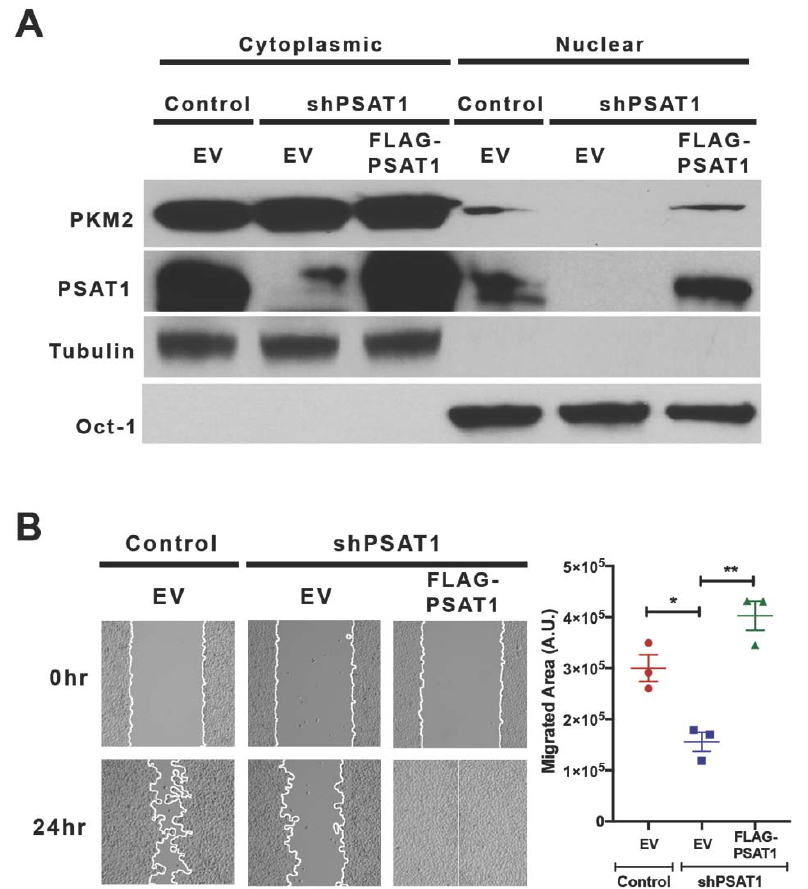
Figure 6. Re-expression of PSAT1 restores the nuclear localization of PKM2 and cell migration in silenced PC9 cells. ( A ) Immunoblot analysis for PKM2 and PSAT1 localization in PSAT1-silenced PC9 cells stably expressing an empty vector (EV) or FLAG-PSAT1. Cytoplasmic and nuclear fractions from the control-EV, shPSAT1-EV, and shPSAT1-FLAG-PSAT1 PC9 cells were analyzed using anti ‐ PKM2 and anti ‐ PSAT1 antibodies. Oct ‐ 1 and α‐ tubulin served as loading controls for the nu ‐ clear and cytoplasmic compartments, respectively. Shown are representative images from three in ‐ dependent experiments. ( B ) Wound healing assay of the control ‐ EV, shPSAT1 ‐ EV, and shPSAT1 ‐ FLAG ‐ PSAT1 PC9 cells. Shown are representative images at 0 h and 24 h. The migrating cells are demarcated by continuous white lines. Data are presented as a mean ± SE migrated area after 24 h from three independent experiments. A statistical significance was determined by a one ‐ way ANOVA with Tukey’s multiple comparison test. ** p < 0.005 and * p < 0.05. A.U .: arbitrary unit .